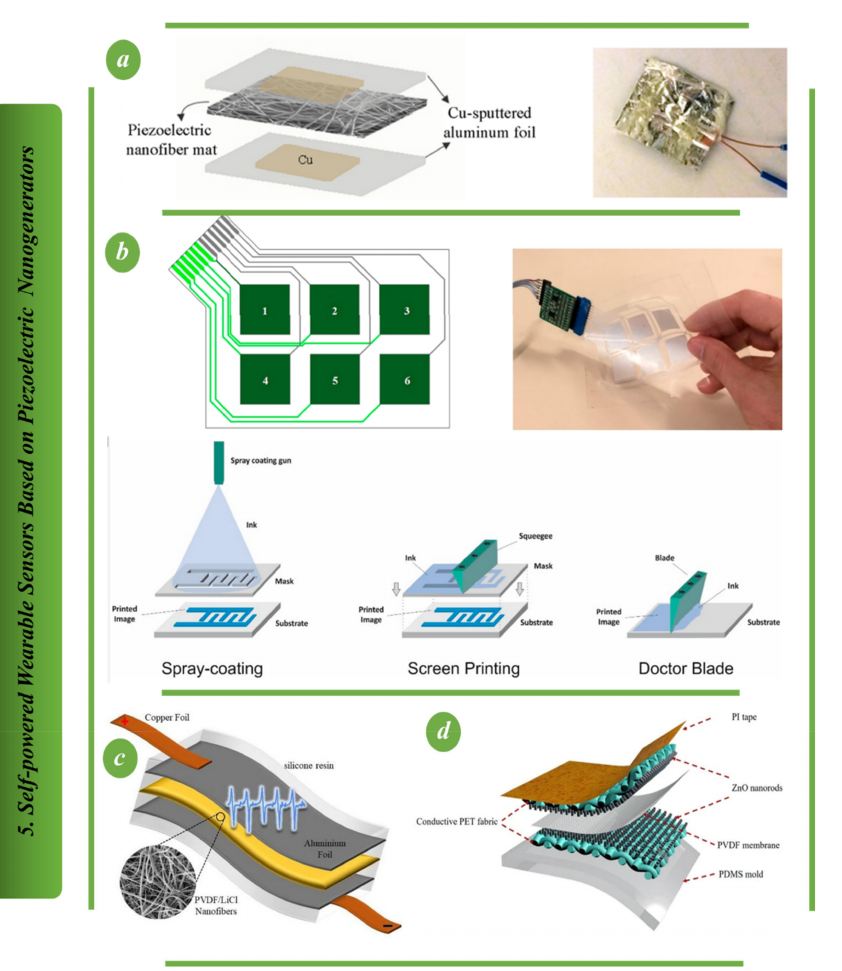
Figure 9. Self-powered wearable sensors based on PENG: ( a ) A unique piezoelectric sensor that may be worn and is based on a polymer (PVDF) [97]. ( b ) The mechanism of piezoelectric printed touchscreens [98]. ( c ) The polyvinylidene fluoride (PVDF)/LiCl nanogenerator device’s structural composition [99]. ( d ) The highly effective piezoelectric pressure sensor for textiles (T-PEPS)